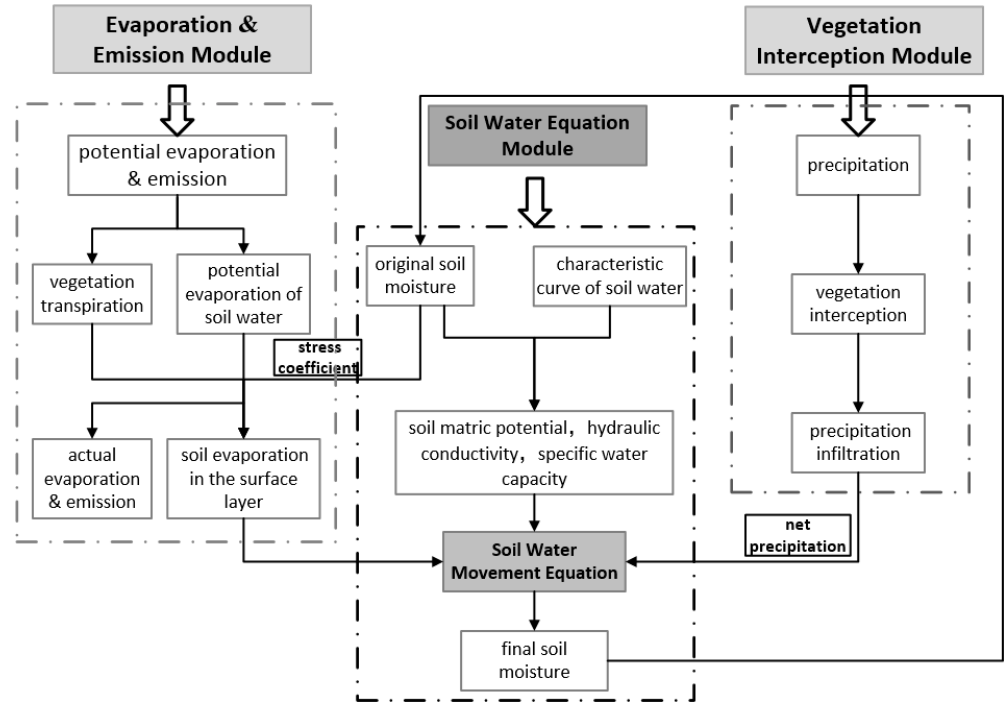
Figure 3. Soil Plant Atmosphere Continuum energy and moisture calculation process (Yang et al., 2015 [50]).